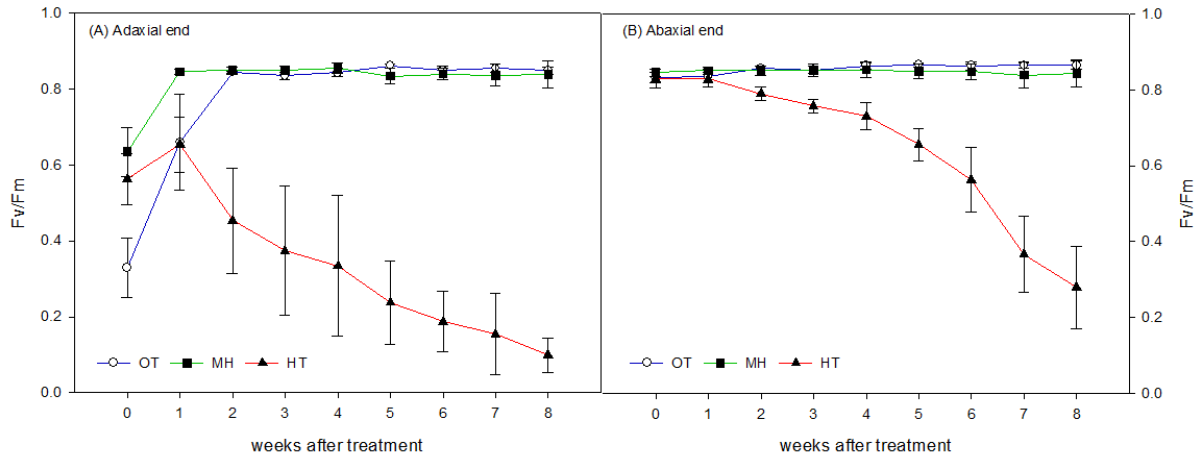
Figure 4. The PSII efficiency (Fv/Fm) on the adaxial ( A ) and abaxial ends ( B ) of shoots under control (OT, 30 °C/20 °C), moderately high temperature (MH, 35 °C/25 °C), and high temperature (HT, 40 °C/30 °C) treatments during the experiment in 2017. Each value represents the mean ± SD of five potted plants. Between one and three positions were measured in each potted